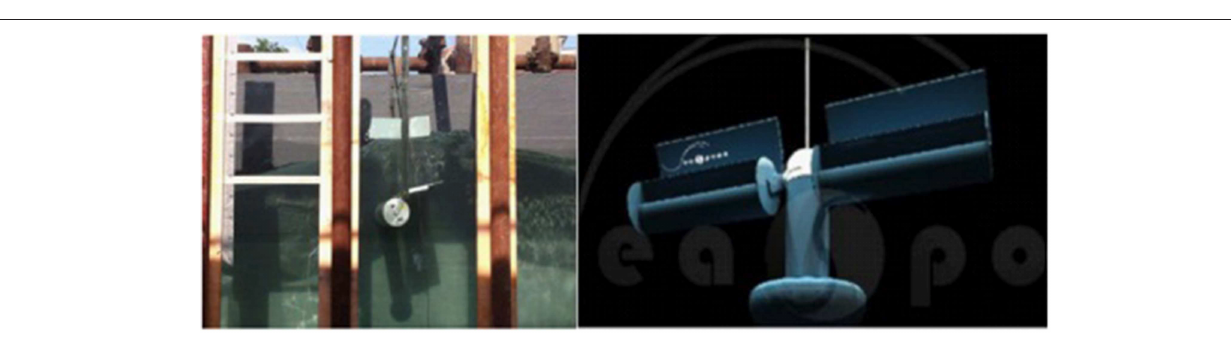
FIGURE 7 | Small Scale prototype (Left) and schematic representation of Seaspoon (Right)